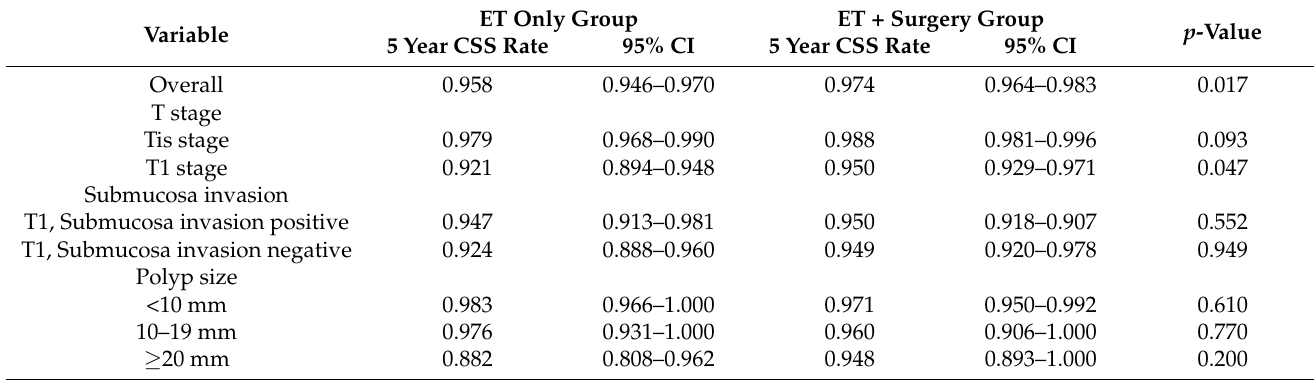
Table 3. Univariate Cox regression analysis.